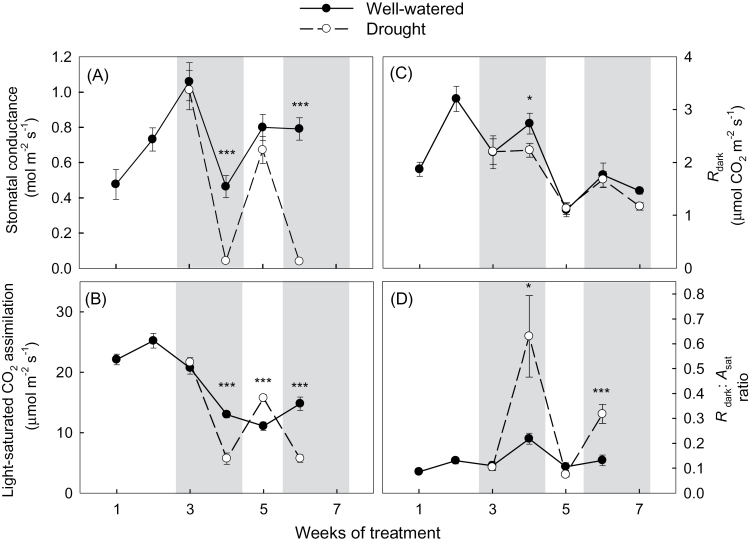
Effect of periodic drought on: (A) stomatal conductance under saturating irradiance (g
s); (B) light-saturated photosynthesis (A
sat); (C) leaf dark respiration (R
dark); and (D) R
dark/A
sat ratios of Eucalyptus globulus fully expanded leaves (measured over several weeks commencing early November 2010). Within each plot, values of well-watered (filled circles) and drought-treated (open circles) plants are shown (n=12; ±SE); values shown are averages of plants grown under two atmospheric CO2 concentrations (400 μmol mol–1 and 640 μmol mol–1 for ambient and elevated [CO2], respectively) and two growth temperatures (T, ambient and ambient +3°C) scenarios. The shaded regions designate two periods of controlled drought, with the intervening non-shaded region indicating when drought-treated plants were rewatered after the first drought period. Significant Student’s t-test P-values of comparisons between drought and well-watered values are indicated with * for P<0.1, ** for P<0.05, and *** for P<0.01. See Supplementary Figs S2–S5 at JXB online for plots of each parameter showing values within each [CO2] and growth T combination. Note: in week 7, a methodological error occurred when measuring gas exchange under light saturation. As such, data presented for week 7 are limited to R
dark.